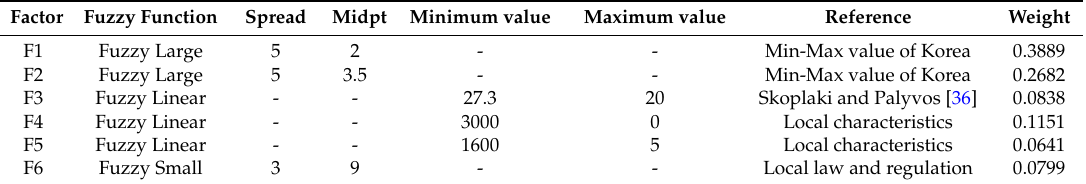
Table 5. Applied fuzzy membership functions and the parameters and derived weight for each factor